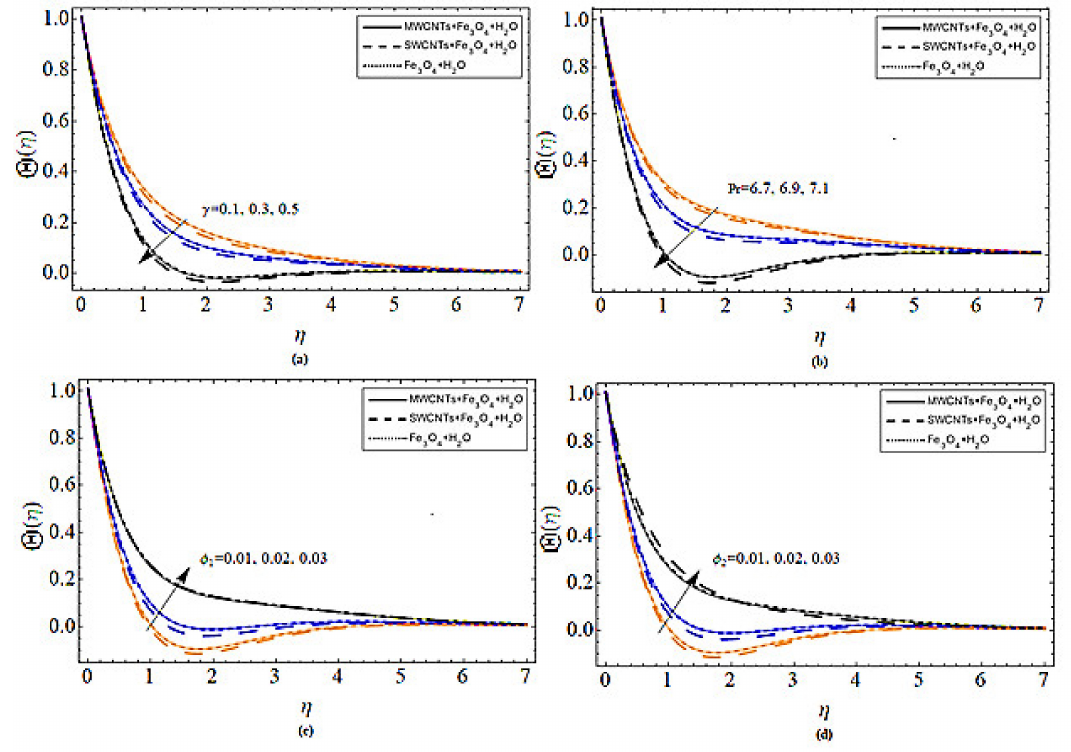
Figure 4. The behavior of energy profile Θ ( η ) versus ( a ) thermal energy ratio parameter γ ( b ) Prandtl number Pr ( c ) volume friction parameter of CNTs φ 1 ( d ) volume friction parameter of ferric oxide φ 2